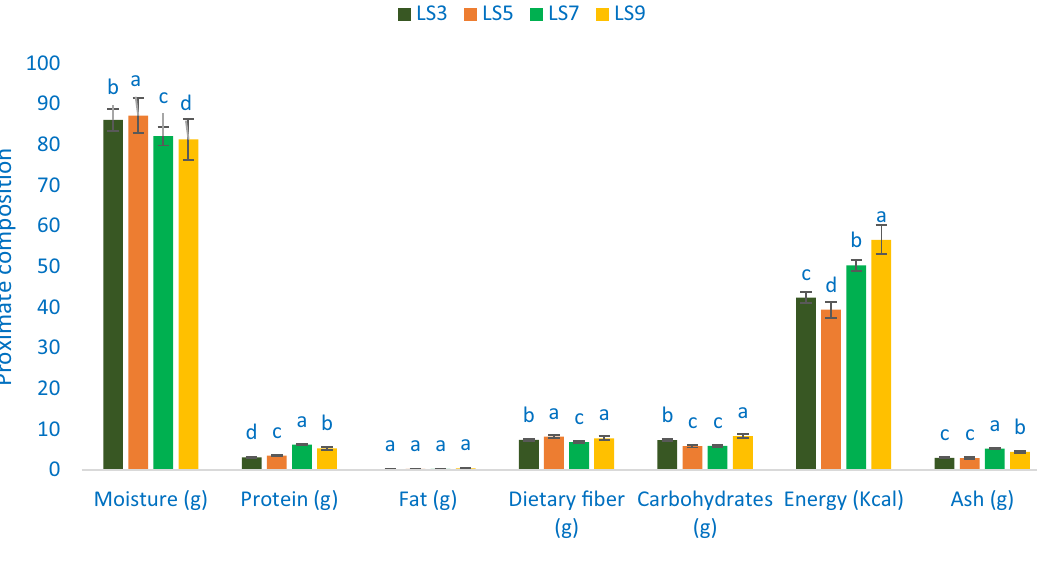
Figure 6. Proximate compositions (per 100 g −1 FW) in four selected A. gangeticus leafy vegetables; different letters are differed significantly by Duncan Multiple Range Test (P < 0.01), (n =